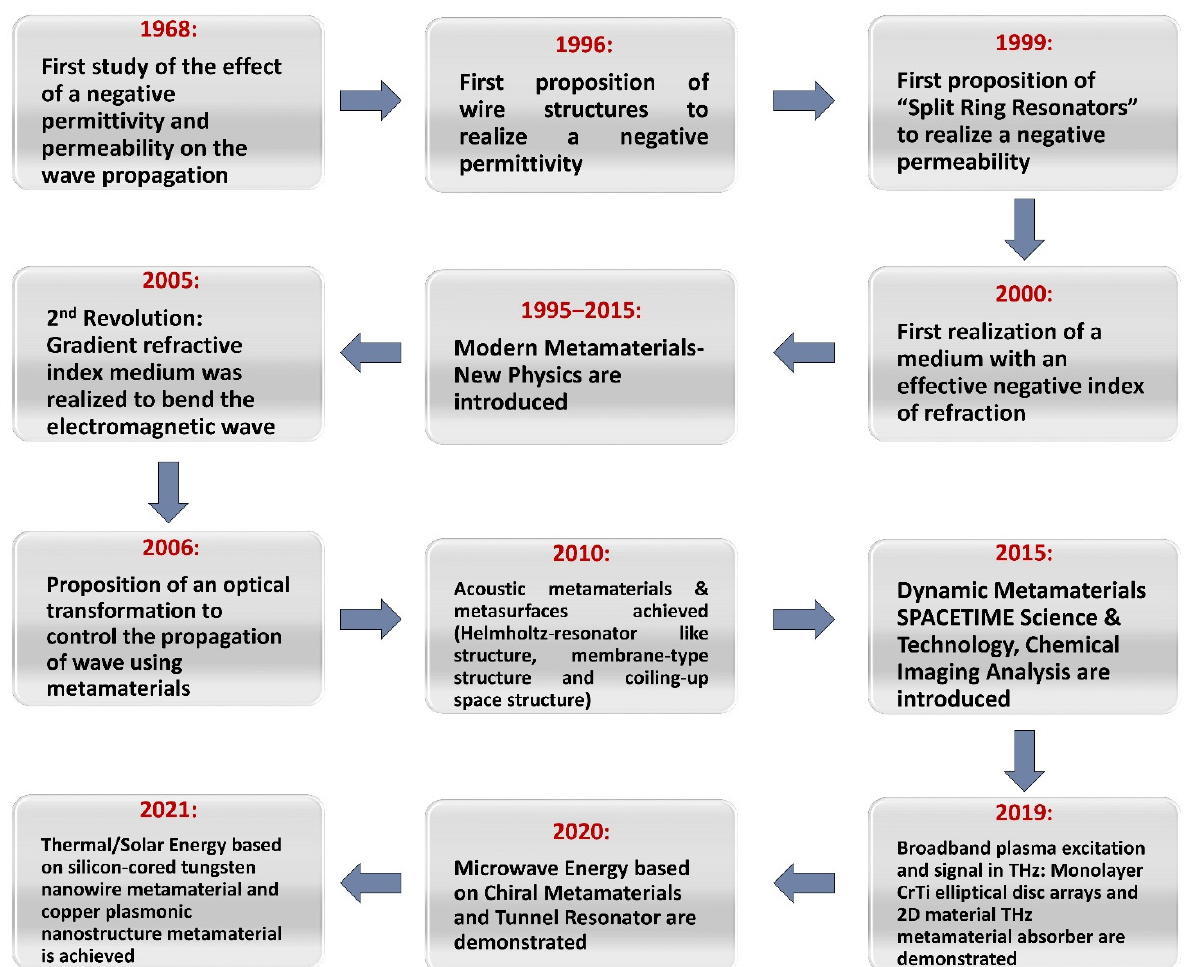
Figure 1. Schematic depicting the evolution of the field of metamaterials over the years, from 1968 to nowadays. to